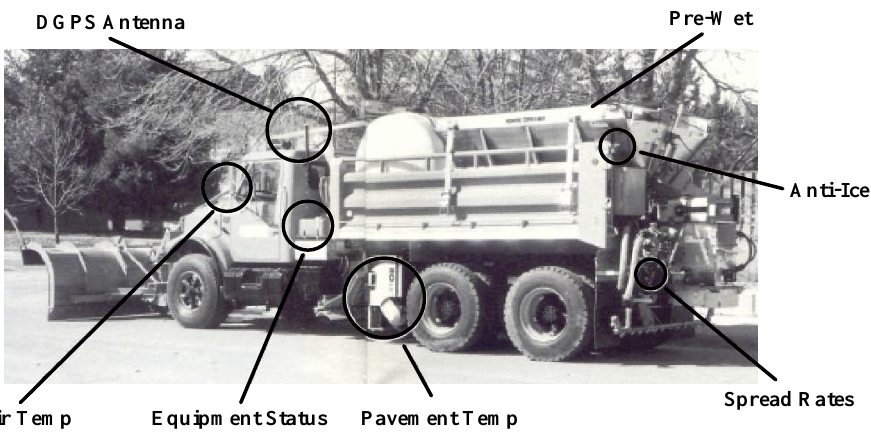
Figure 11. Winter maintenance vehicle wired with sensors and DGPS